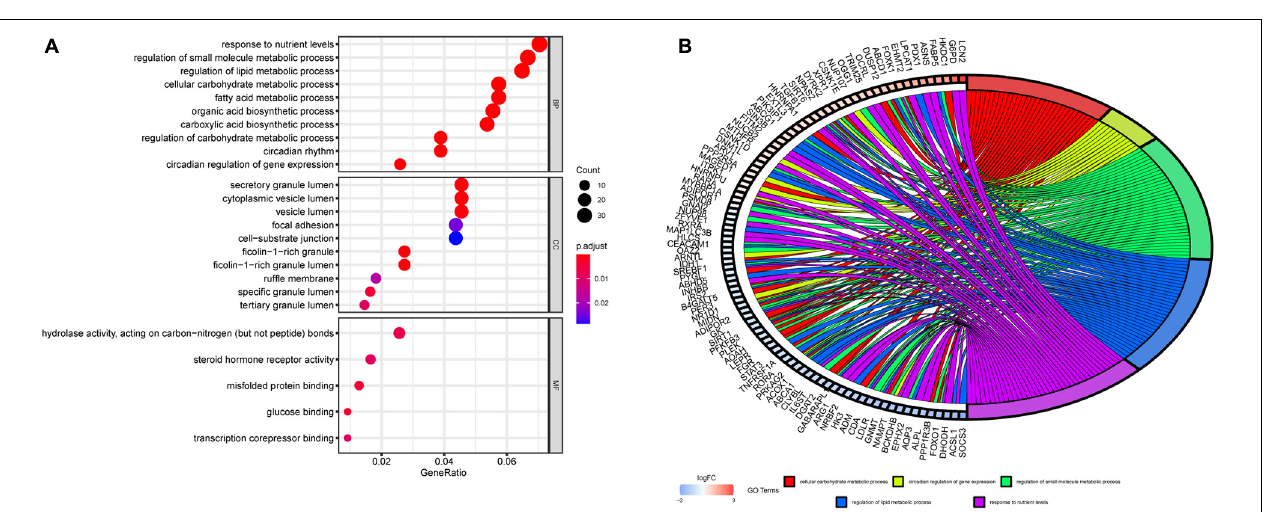
FIGURE 2 | Identification of DERGs. (A) Intersection map of genes in the LIHC and CGDB datasets. (B) Volcano plot of DERGs. The green and red dots represent the downregulated and upregulated genes, respectively.